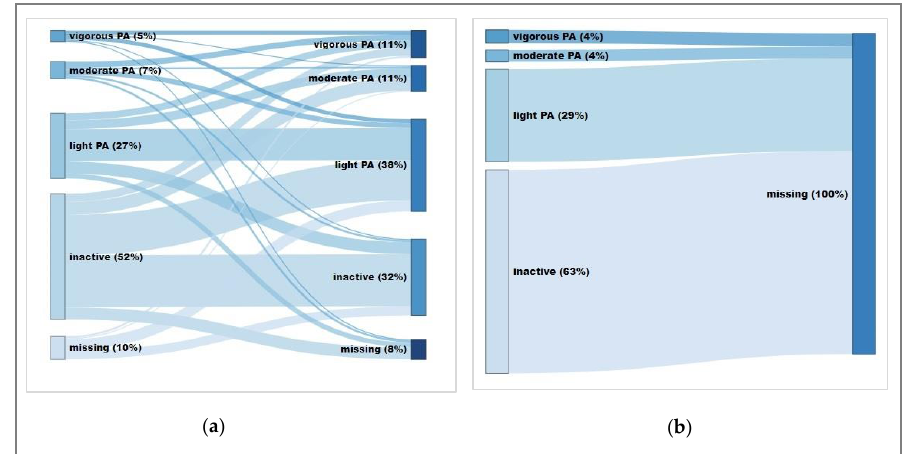
Figure 1. PA trajectories of ( a ) participants (study sample with PA data for at least one assessment point ( n = 240)) and ( b ) non-participants with baseline PA data ( n = 247). Inactive: no activity; light PA: <150 min/week; moderate PA: 150- <300 min/week ; high PA: ≥300 min/week. Software: displayr.com (Displayr, Sydney, Australia). Int. J. Environ. Res. Public Health 2020 , 17 , x